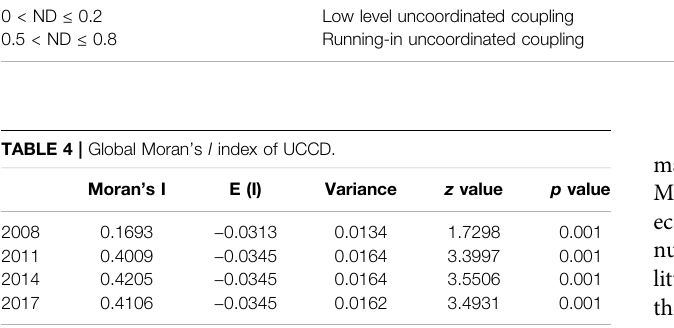
Frontiers in Environmental Science |